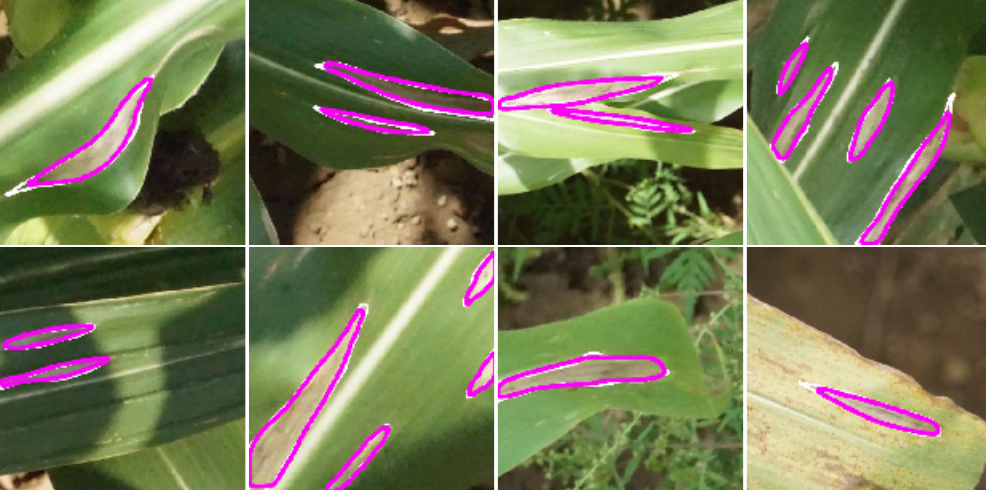
Figure 2. Ground truth (white) and predicted (magenta) lesion